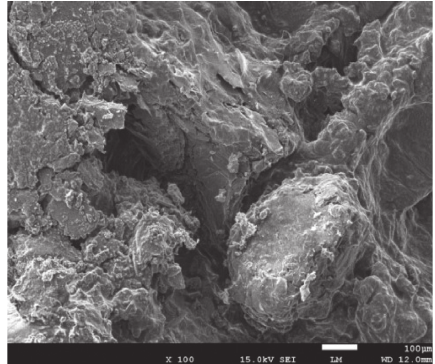
Figure 13: Bonding interface between asphalt and ore in fiber free asphalt mixture.